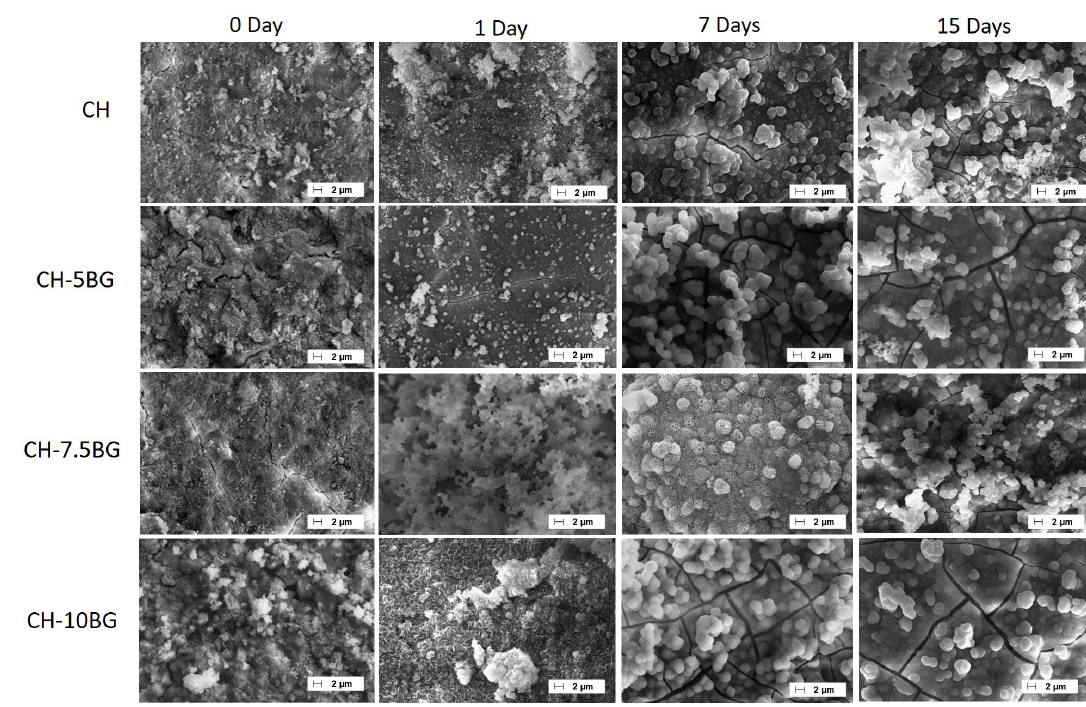
Figure 3. SEM micrographs for blends based on homogeneous calcium aluminate cement (CH) containing different contents of bioactive glass (BG), without or with SBF treatment for 1, 7 and 15 days. The fractures in the newly developed layers were caused by the drying of the